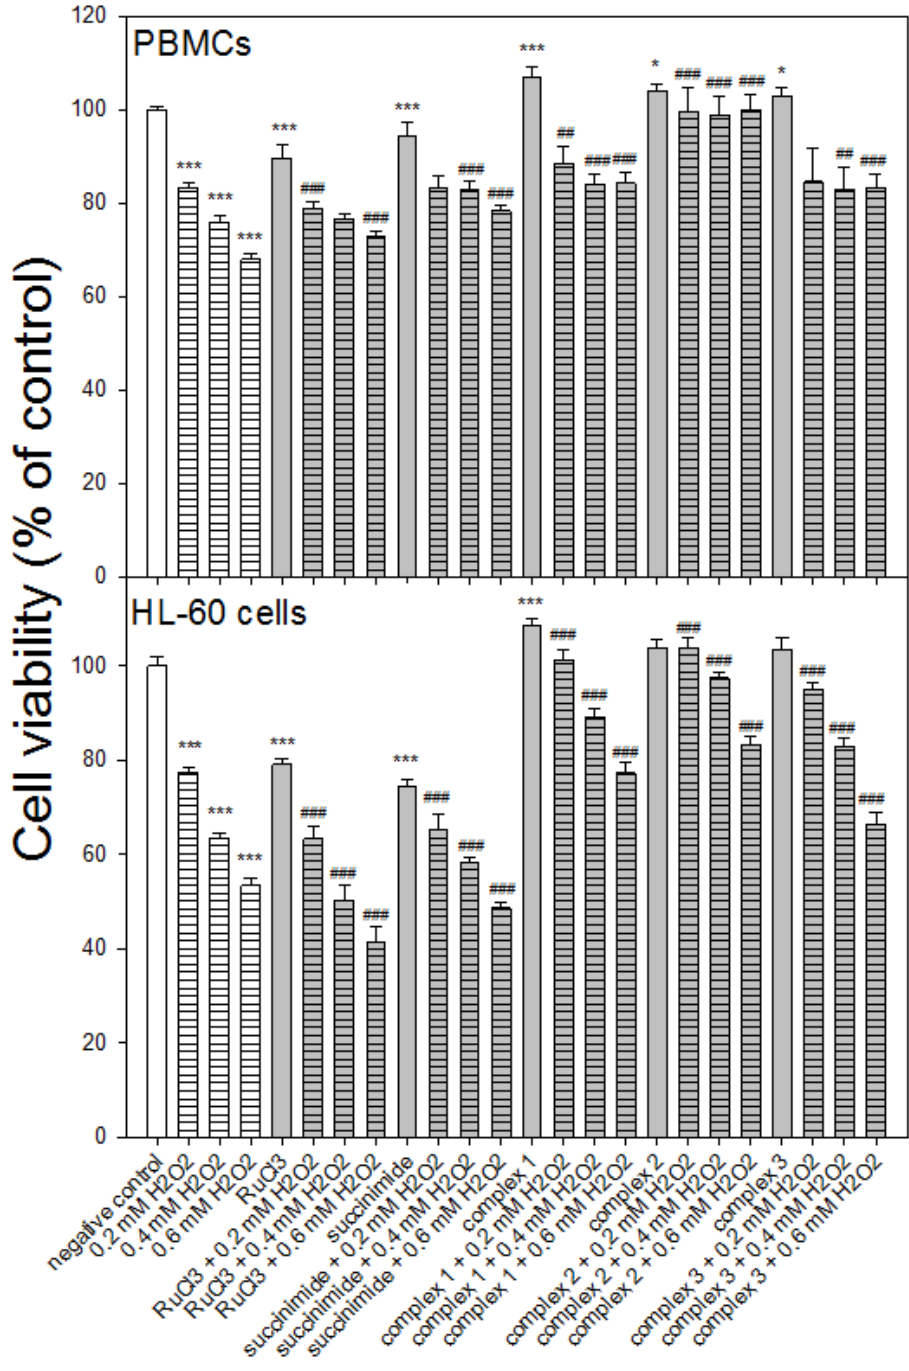
Figure 2. Effect of ruthenium complexes 1 – 3 at 50 µ M on the viability of PBMCs and HL-60 cells incubated with H 2 O 2 . The viability for individual samples was calculated relative to negative control (untreated cells) ± SD. Cell viability in the control was taken as 100%, n = 6, * p < 0.05, *** p < 0.001 vs. negative control, ## p < 0.01, ### p < 0.001 vs. H 2 O 2 .